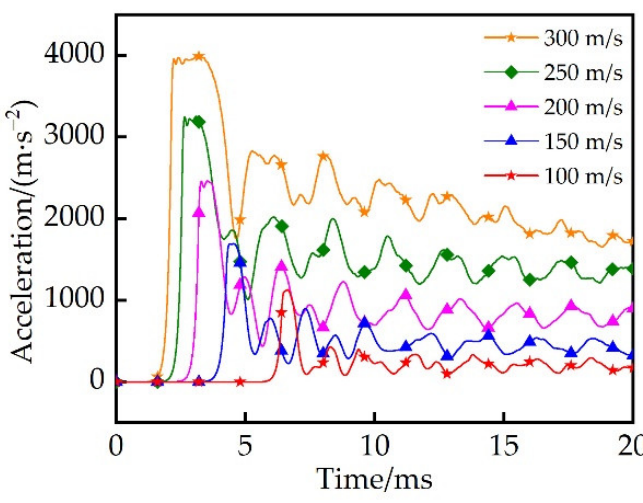
Figure 14. Time–history acceleration at different speed of water entry.